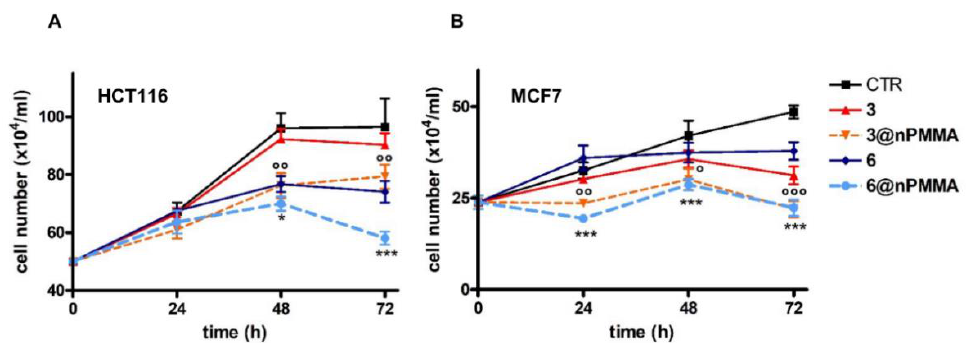
Figure 9. Growth curves of HCT116 ( A ) and MCF7 ( B ) spheroids following 24 h treatment with 3 , 3@nPMMA , 6 and 6@nPMMA at concentrations corresponding to the IC 50 values obtained